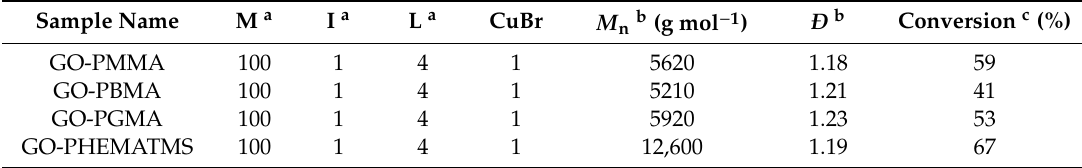
Molar ratios of individual reactants and characterization of polymers grown form sacrificial initiator.